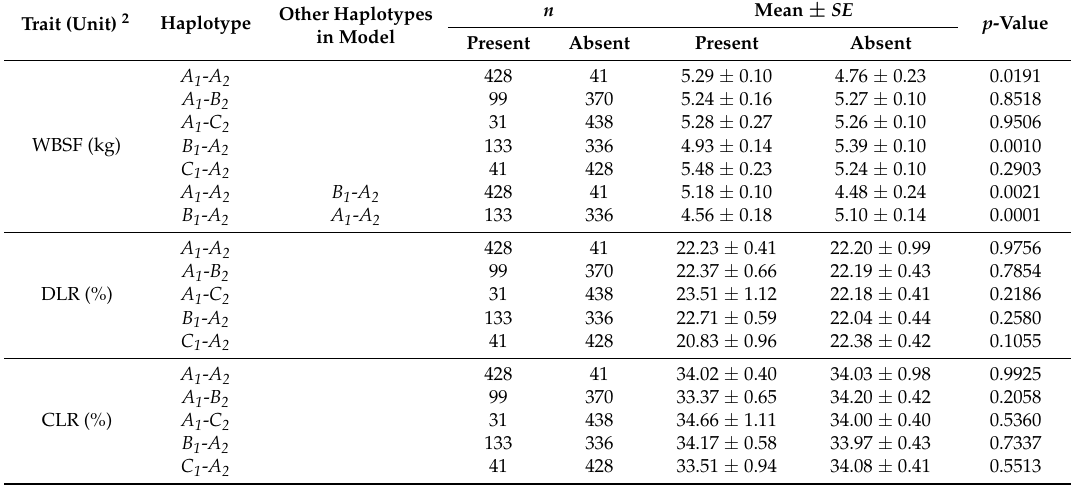
1 Estimated means, their standard errors ( SE s), and p -values derived from general linear mixed models. 2 HCW represents hot carcass weight, REA represents rib eye area, WBSF represents Warner–Bratzler shear force, DLR represents drip loss rate, and CLR represents cooking loss rate.